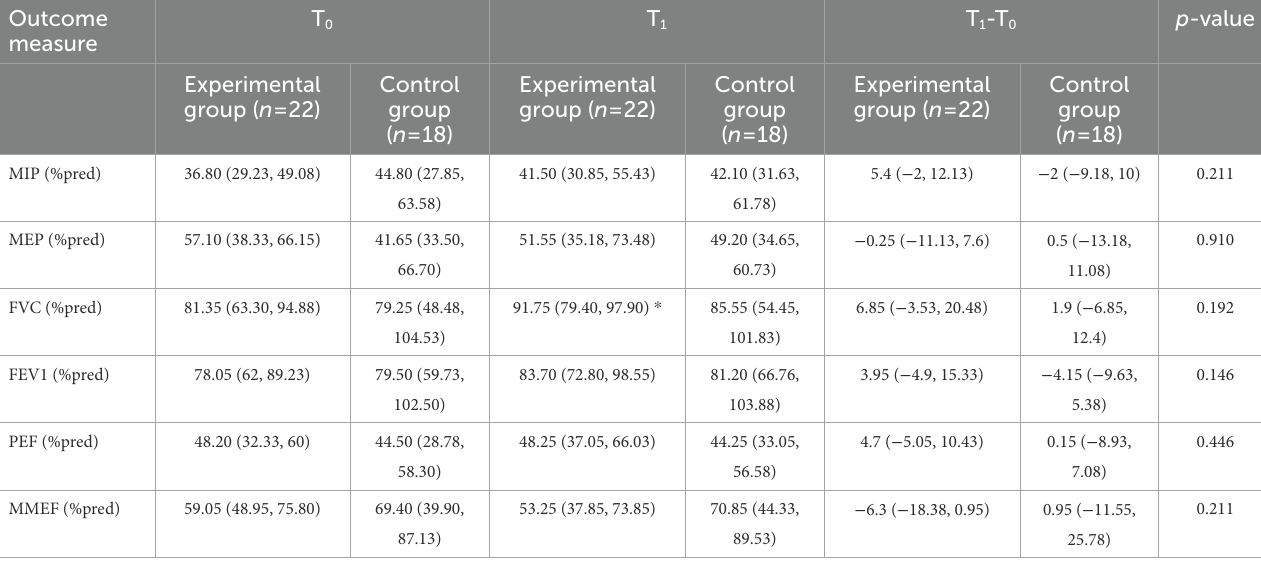
TABLE 4 Comparison of lung function